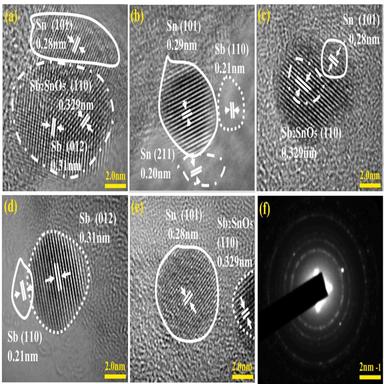
(a-e) HRTEM images from the Sn/Sb@SSO@PCFs samples and the accompanying Fourier transform images for randomly selected five regions in the samples. and (f) SAED patterns for corresponding.